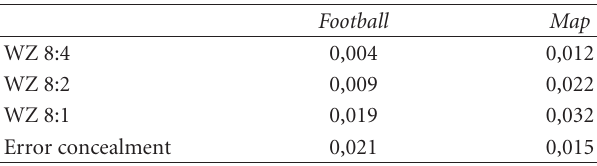
Figure 5: Evolution of normalized MSE transmission correction as a function of the incoming slice error rate. Table 4: Average distortions associated with each frequency-filtered version and error concealment for the Football and Map sequences.